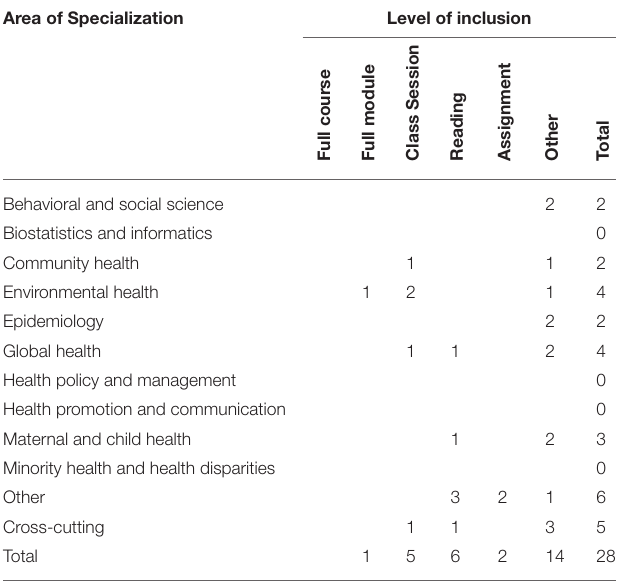
TABLE 2 | Level of Inclusion of menstruation-related topics in public health courses by area of specialization. Area of